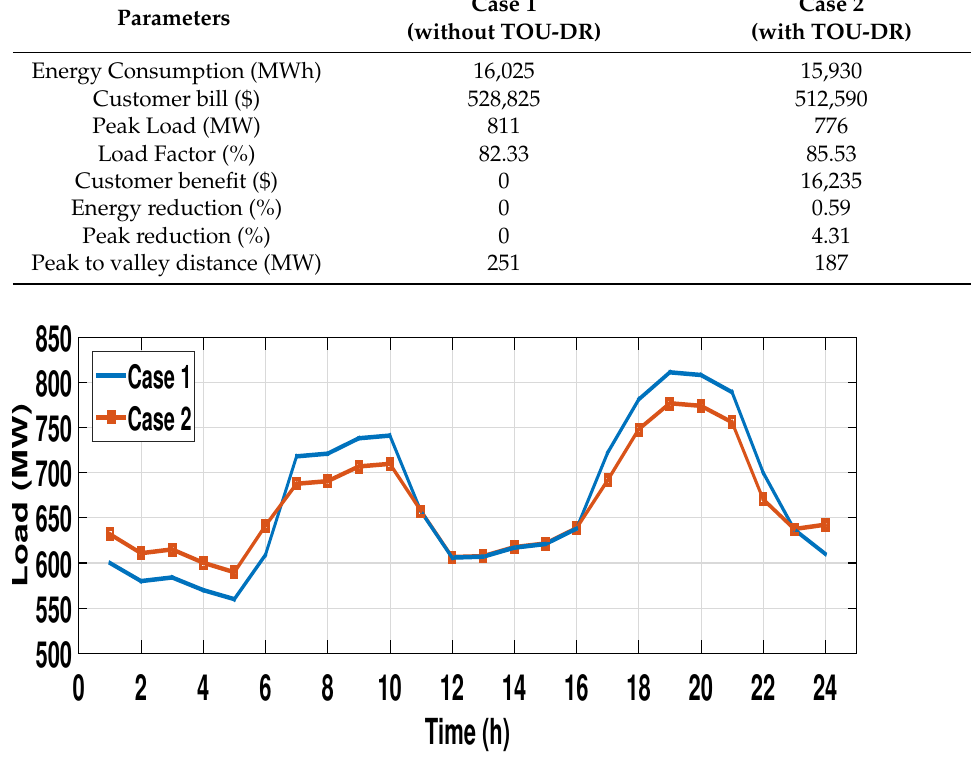
Figure 11. Effect of TOU-DR program on the initial load